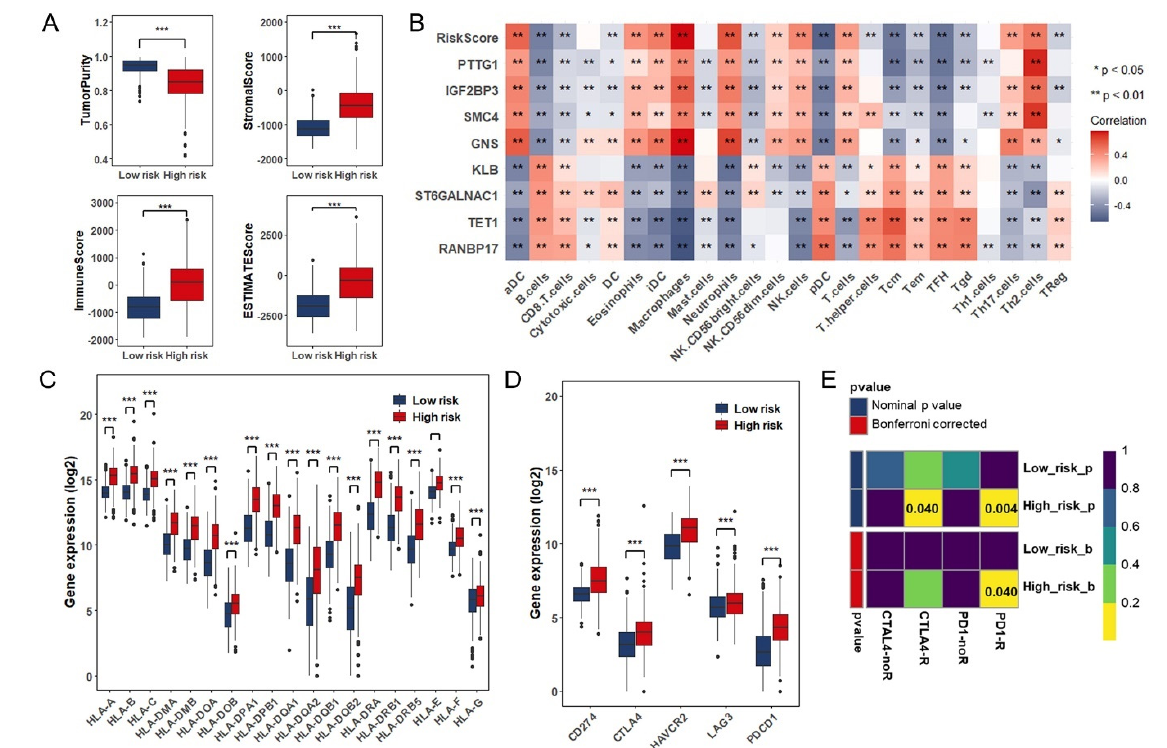
Figure 6. Estimation of tumor-infiltrating immune cells and prediction of responses to immune checkpoint inhibitors: ( A ) Comparison of tumor purity, estimate score, immune score, and stromal score between low-risk group ( n = 346) and high-risk group ( n = 345) in TCGA database. ( B ) Correlation matrix of risk score, eight immune-associated RBPs and 24 types of tumor-infiltrating immune cells. ( C ) The expression level of HLA family genes in low- and high-risk groups in TCGA database. ( D ) The expression level of CD274 (PD-L1), CTLA4, HAVCR2, LAG3, and PDCD1 (PD1) in low- and high-risk groups in TCGA database. ( E ) Sensibility of response to PD1 and CTLA4 inhibitors of patients in low- and high-risk groups. *, p < 0.05; **, p < 0.01; ***, p < 0.001.